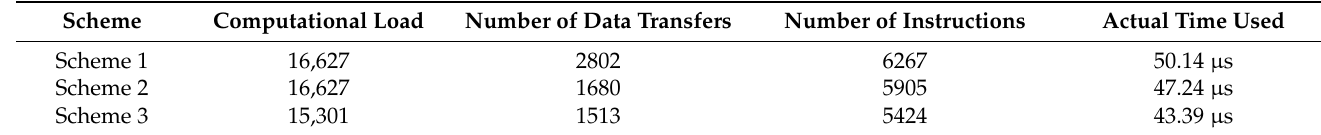
Table 2. Comparison of the compilation results of different